Question: Looking at the figure, what chart type is it?
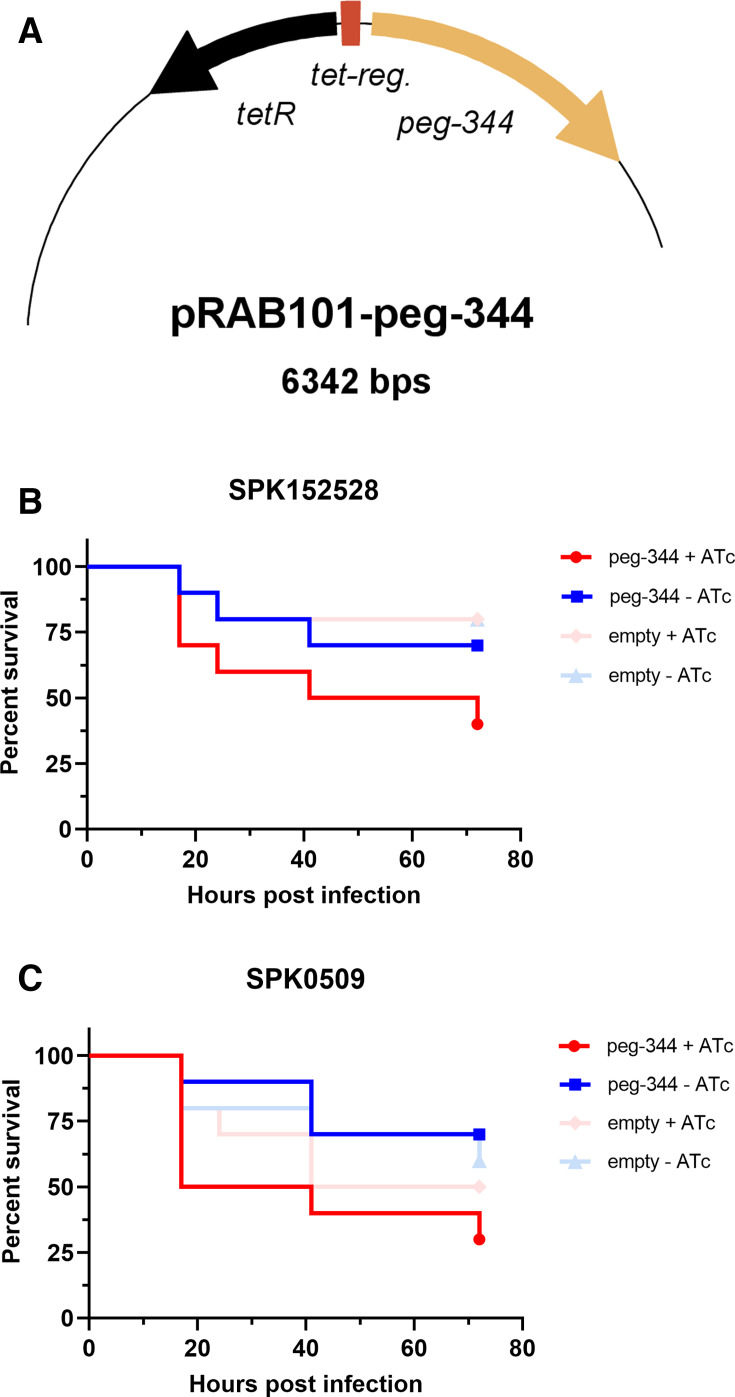
Answer: survival